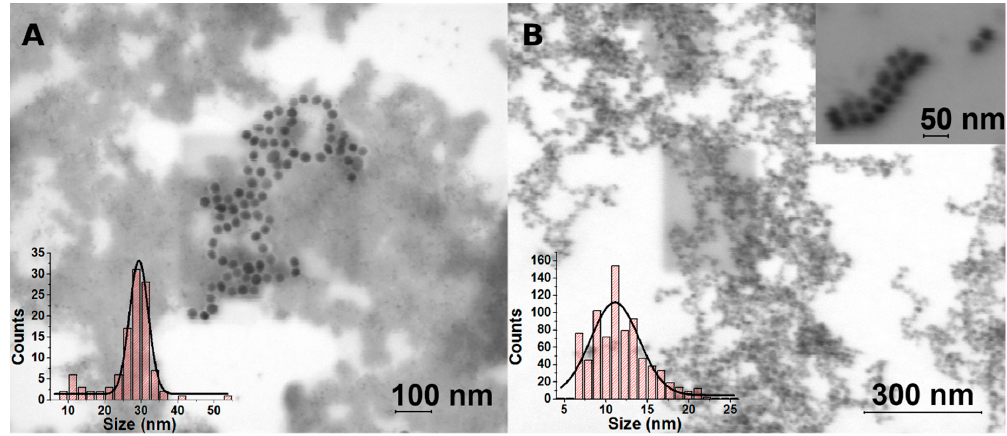
Figure 1. Bright-field scanning transmission electron microscopy (STEM) images: ( A ) SPION-PEG, ( B ) SPION-CCh.